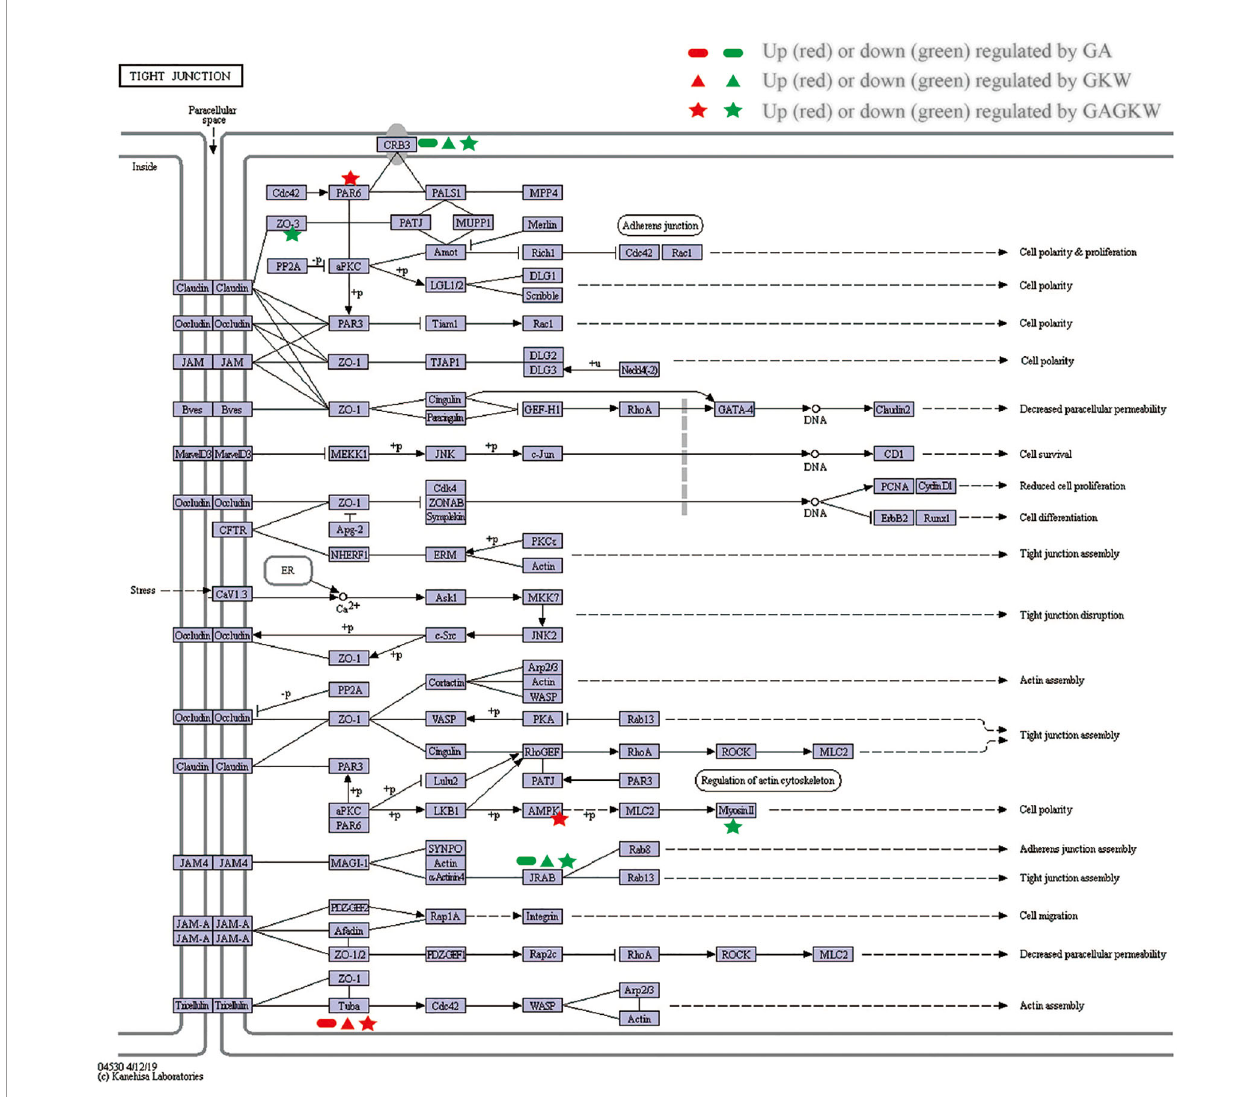
FIGURE 8 | KEGG Pathway map for tight junction. Regulated genes are signed with indicated characters and